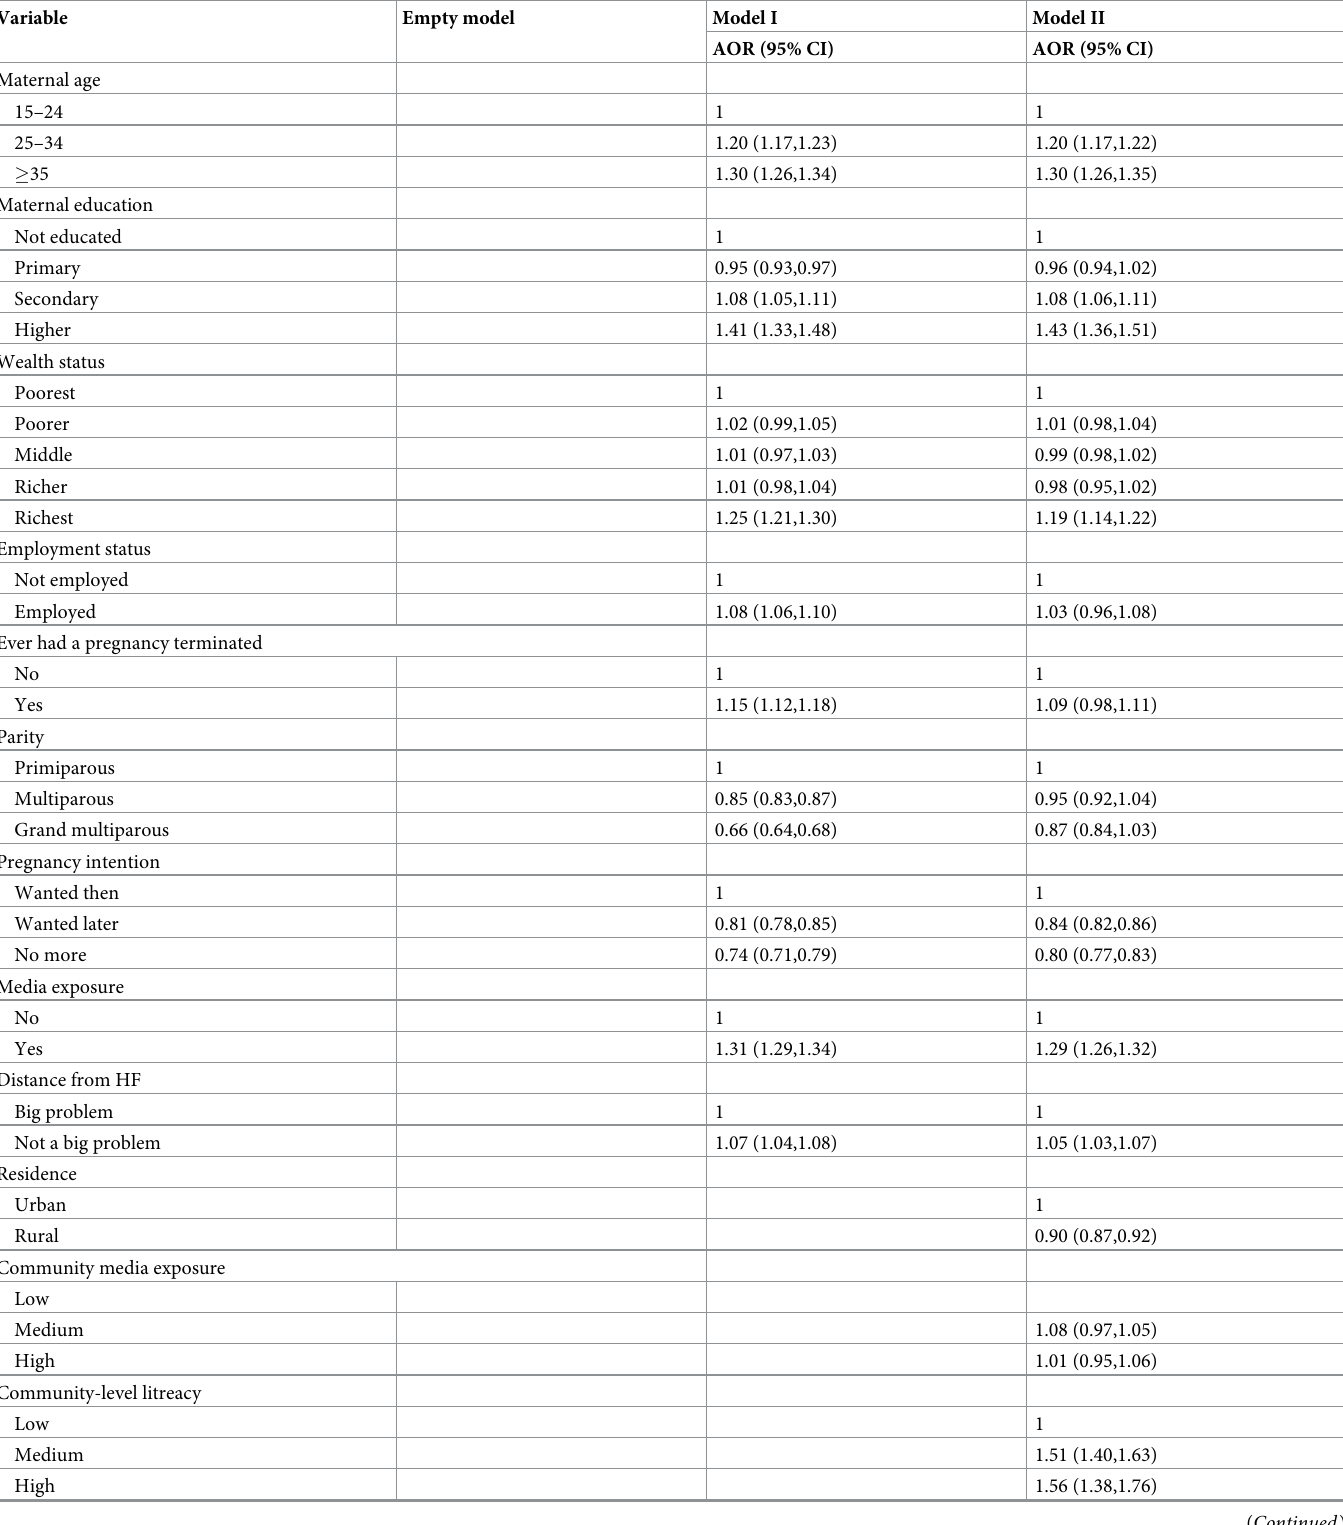
Table 3. Multilevel logistic regression analysis to assess factors associated with timely initiation of first ANC visit in reproductive-age women in